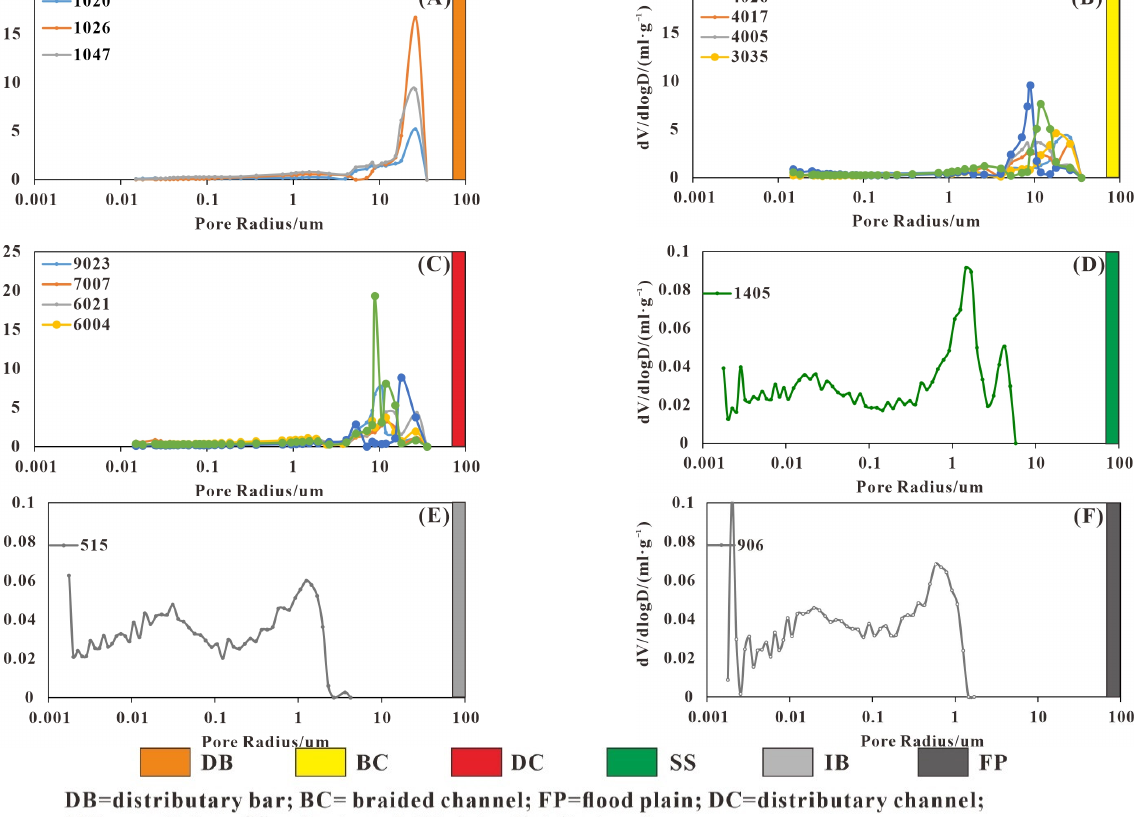
Figure 13. Pore size distribution of different sedimentary microfacies reservoirs. ( A ) Pore size dis- tribution of DBs. ( B ) Pore size distribution of BCs. ( C ) Pore size distribution of DC.s ( D ) Pore size distribution of SSs. ( E ) Pore size distribution of FPs. ( F ) Pore size distribution of IBs.